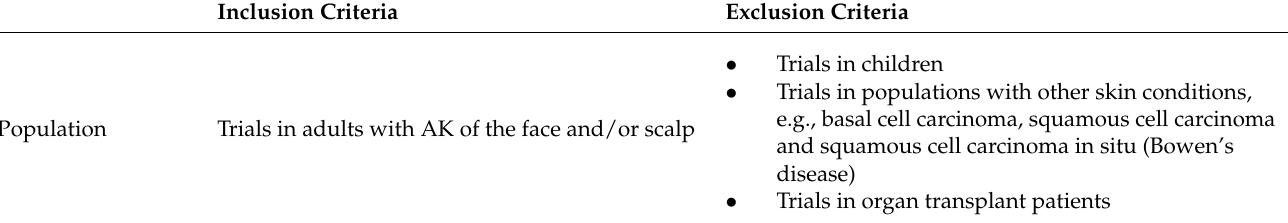
Table 1. Eligibility criteria for the global